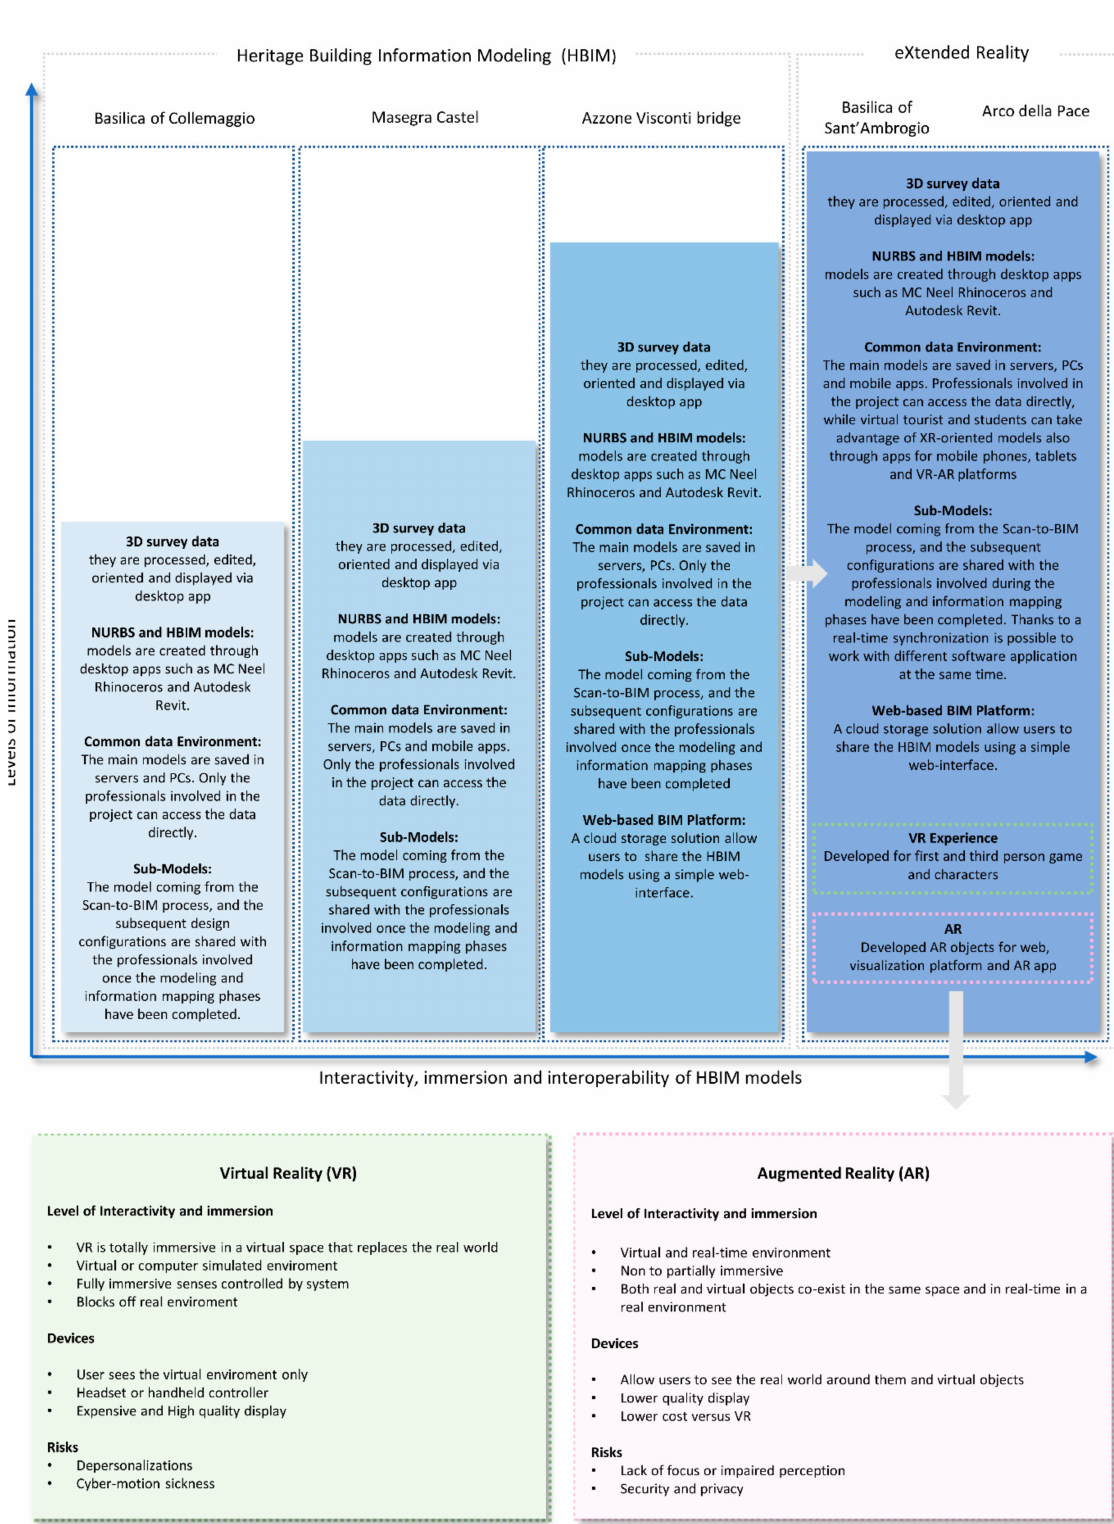
Figure 19. Comparison between research case studies and VR-AR projects focused on the devices and the level of interactivity and immersion